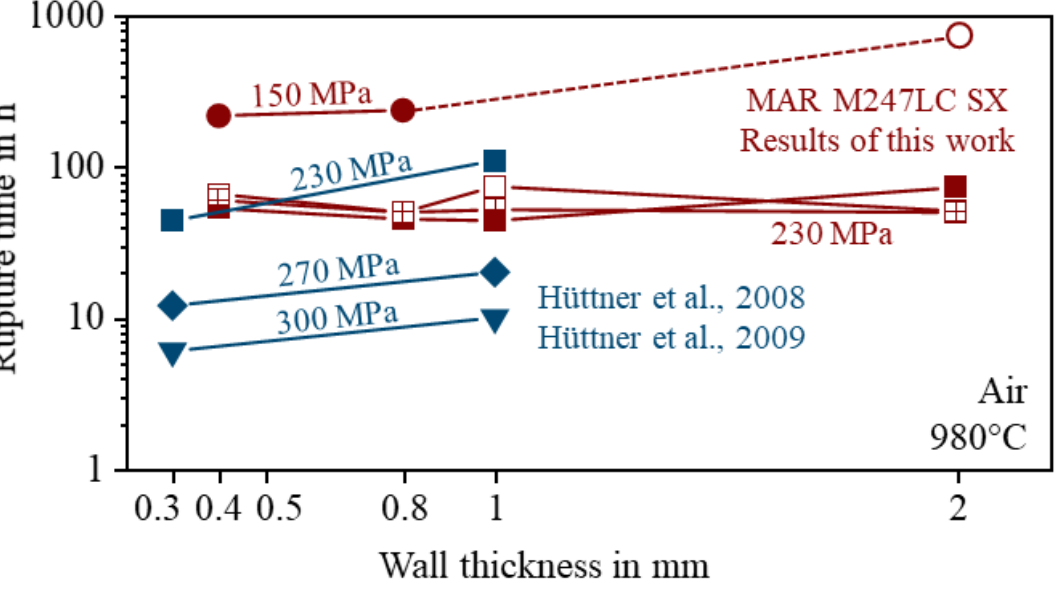
Figure 9. Summary of the results of this work in comparison to literature: rupture time over wall thickness at 980 °C in air; Data from [14,15].